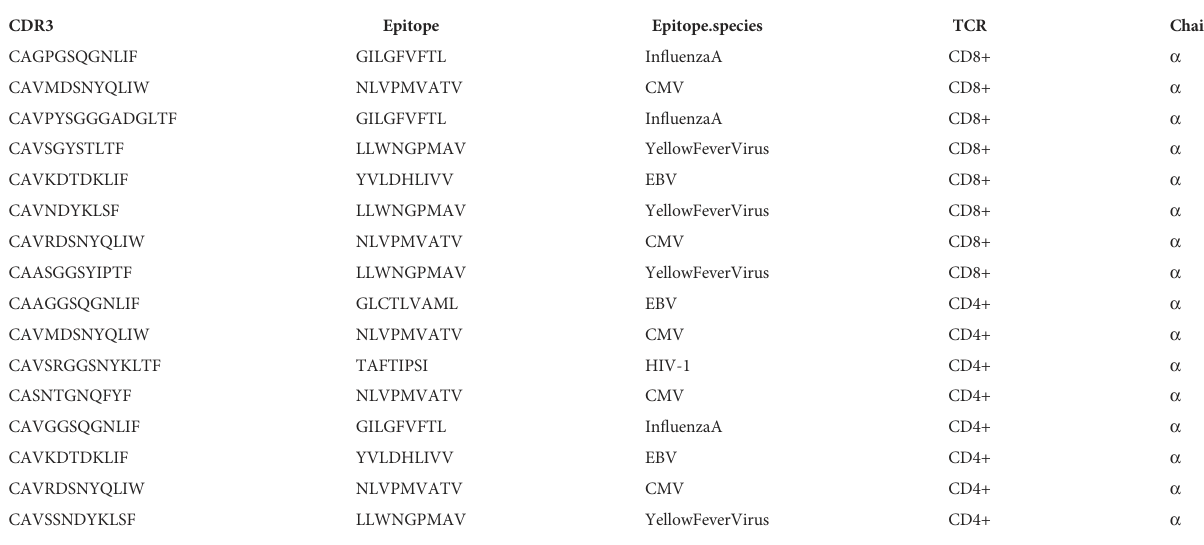
TABLE 2 Public TCR sequences compared to VDJdb.